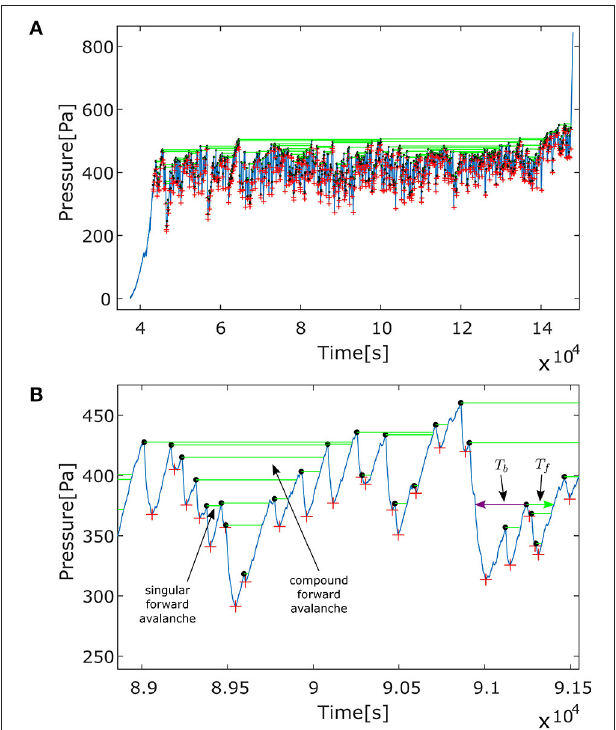
FIGURE 8 | (A) Full Pressure signal from the CWR experiment, black dots and red crosses denote the local maxima and minima of the signal. The forward avalanches are denoted by the green horizontal lines. (B) A zoomed segment of the signal. The sizes T f and T b of forward (green arrow) and backward avalanches (purple arrow) are shown for a particular starting point. Examples of singular and compound forward avalanches are also shown.